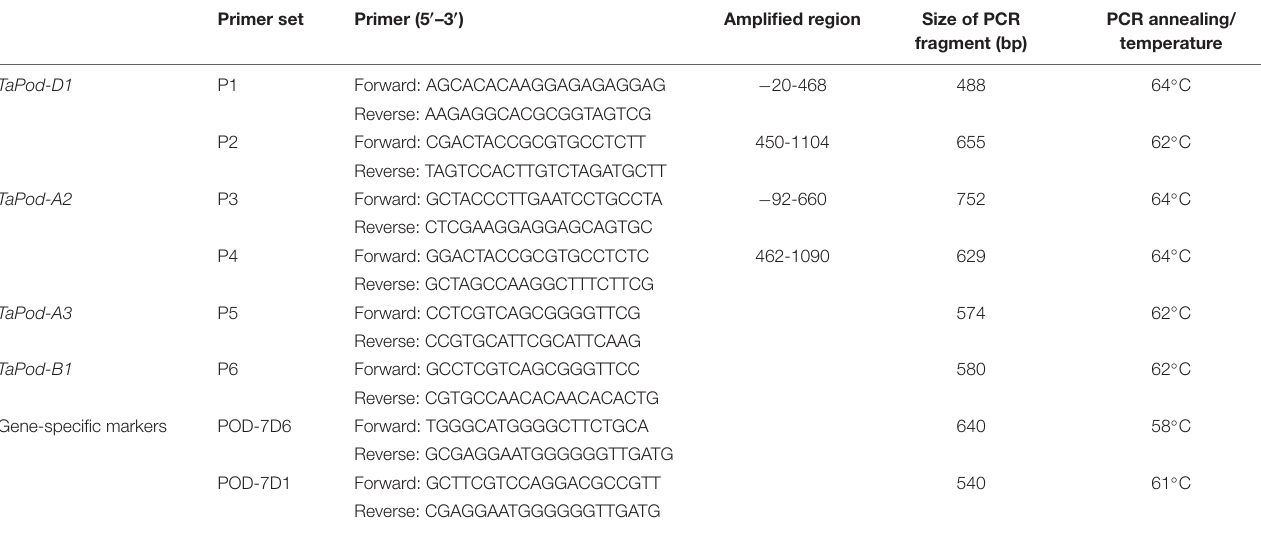
TABLE 1 | The sequences of the primer sets used in the cloning of the POD genes along with their PCR profiles, product sizes. Primer set Primer (5 (cid:48) –3 (cid:48) ) Amplified region Size of PCR